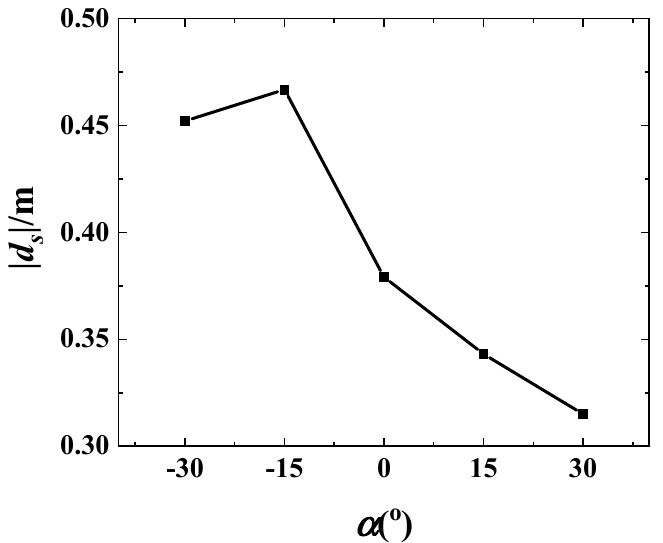
Figure 14. Bed morphology around the cylinder at t = 400 s, ( a – f ) represents Case 1 to Case 6 in Table 2, respectively.